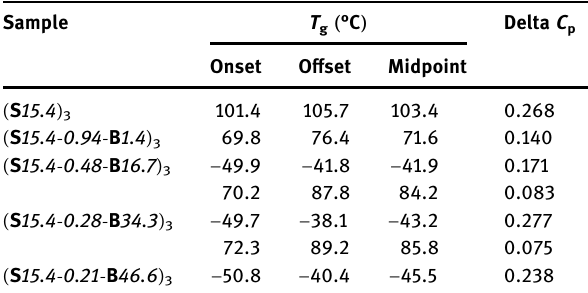
Table 2: Glass transition temperature ( T g ) of the block copolymers Sample T g ( °C )